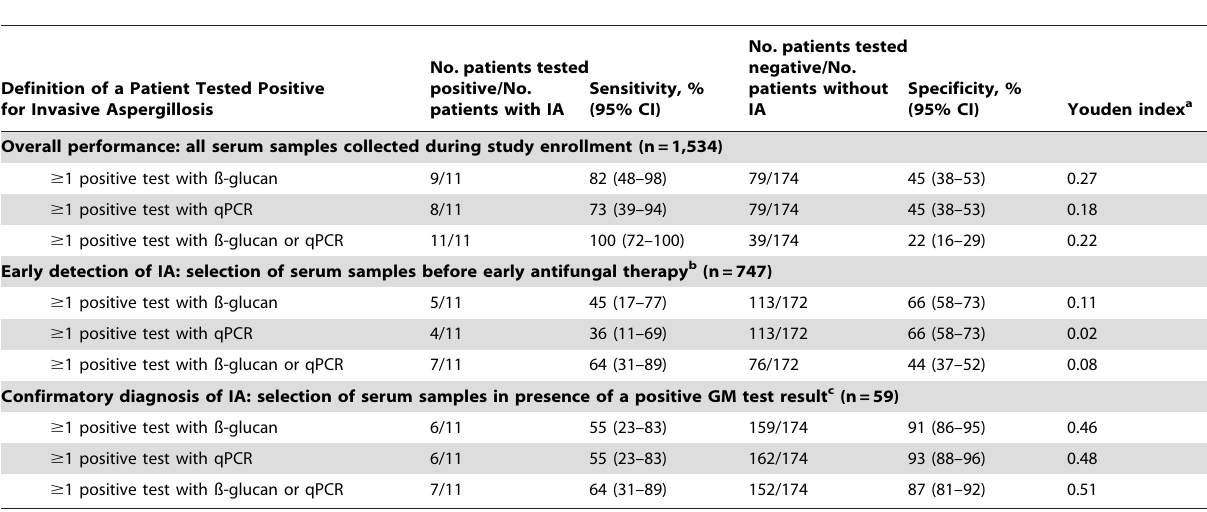
Table 2. Performance of b -glucan and qPCR, overall and according to two restrictive approaches of invasive aspergillosis diagnosis with selection of serum